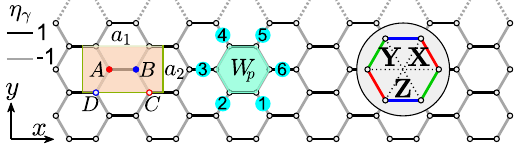
Fig. 1 Lattice geometry. Illustration of an XC6 cylinder on a honeycomb lattice. η γ is + 1 ( − 1) for horizontal (zigzag) bonds. The insets are (left) the unit cell for the zigzag/stripy order with a 1 = 3 ffiffiffi p 3 and a 2 ¼ , (middle) the hexagonal plaquette operator ^ W p with its six sites enumerated, and (right) the X (red), Y (green), and Z (blue) bonds.